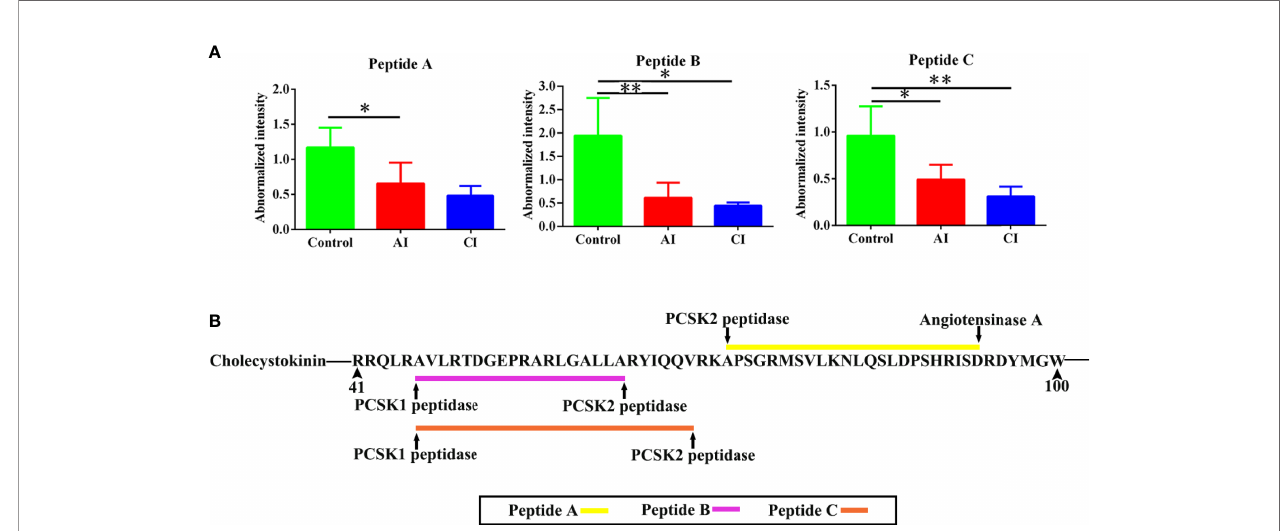
FIGURE 7 | Identi fi cation of novel differentially expressed neuropeptides. (A) Normalized intensity of novel neuropeptides in different groups. (B) The prediction of possible proteases. Two-way ANOVA was used to determine statistical signi fi cance. P values of ≤ 0.05 (*), ≤ 0.01 (**), and ≤ 0.001 (***) were considered statistically signi fi